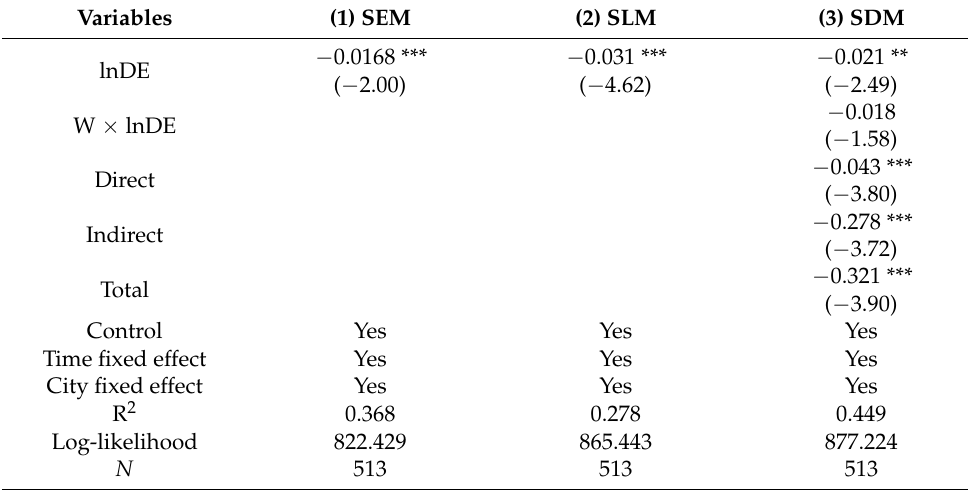
Table 7. The results of the spatial spillover effect.